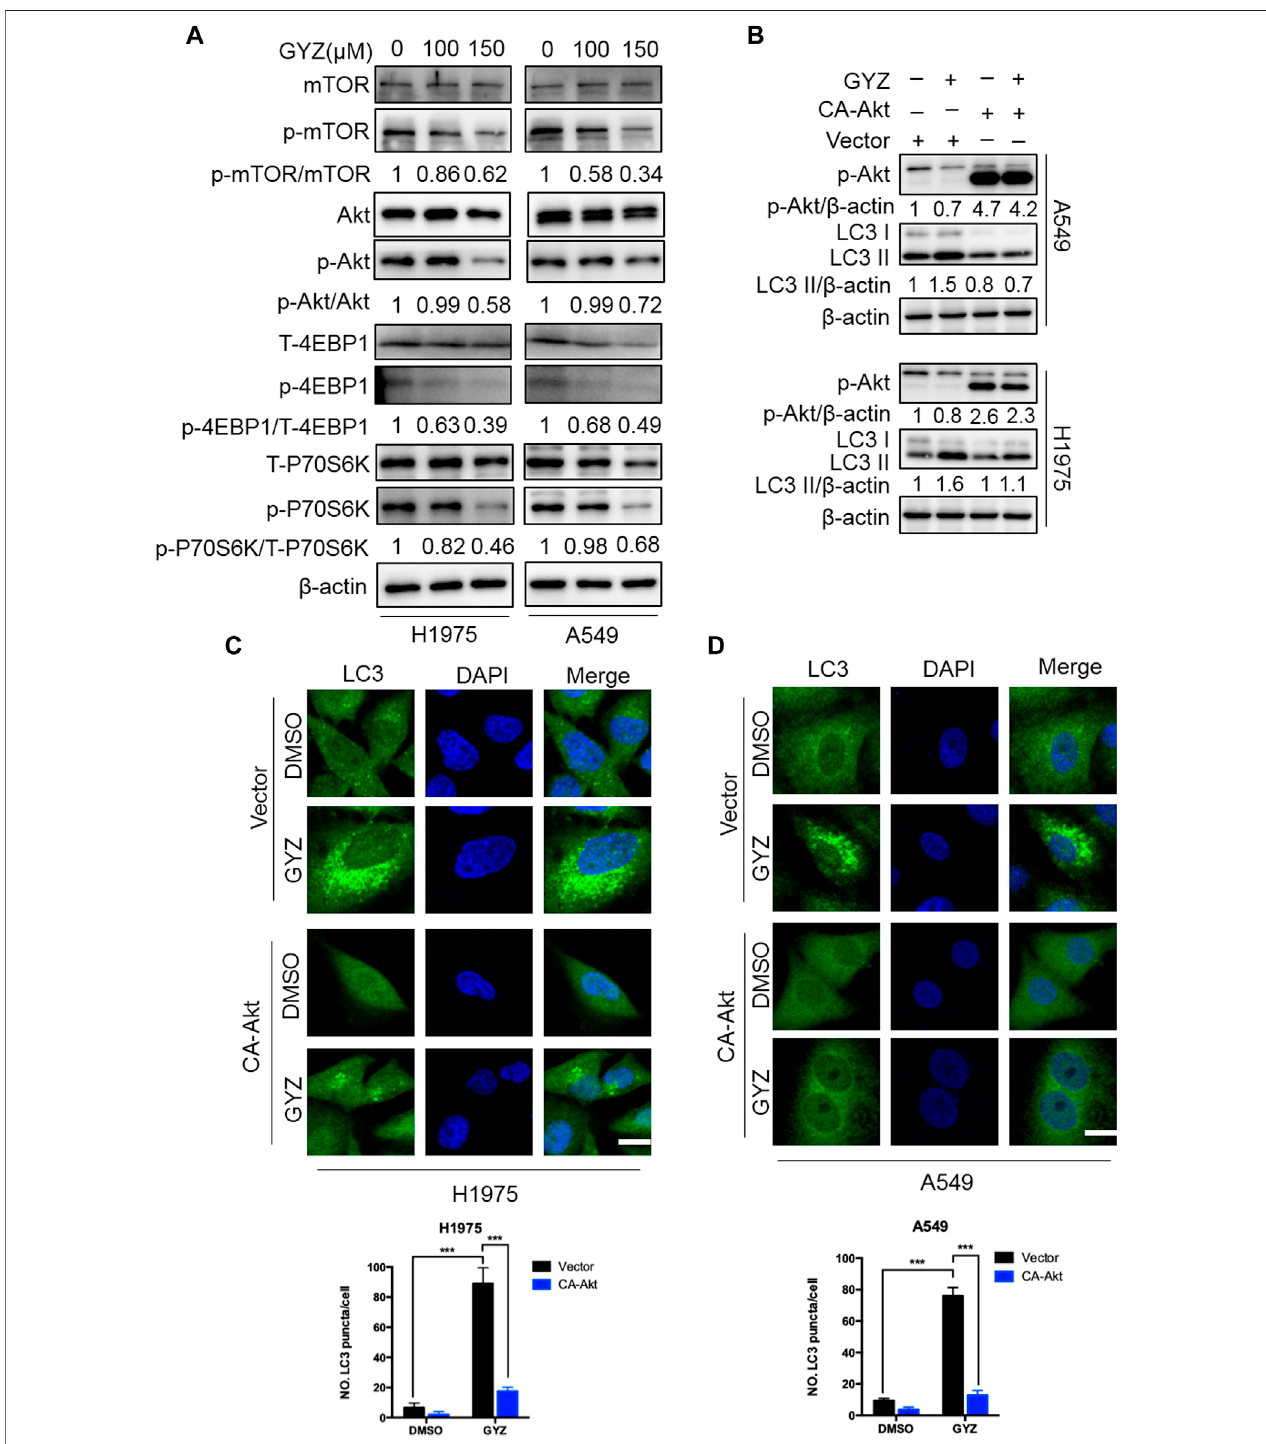
FIGURE 6 | Inhibition of Akt/mTOR signaling is responsible for GYZ-induced autophagy. (A) Immunoblot analysis of phosphorylation of mTOR, Akt, 4EBP1 and p70S6K expression in NSCLC cells treated with the indicated concentrations of GYZ for 24 h. Total mTOR, Akt, 4EBP1, and p70S6K expression was examined as the internal control, respectively. (B) Cells were transfected with empty vectors (pECE) or with constitutively active CA-Akt plasmids for about 36 h, and then cells were treated with GYZ (150 μ M) for another 24 h. Akt phosphorylation, and LC3 turnover were detected by immunoblotting. (C,D) H1975 cells (C) and A549 cells (D) were transfected with constitutively active CA-Akt plasmids or with empty vectors (pECE) for about 36 h in the absence or presence of GYZ (A549 150 μ M, H1975 100 μ M) for 24 h. Scale bars, 10 μ m. All data are means ± SD. *** p < 0.001.